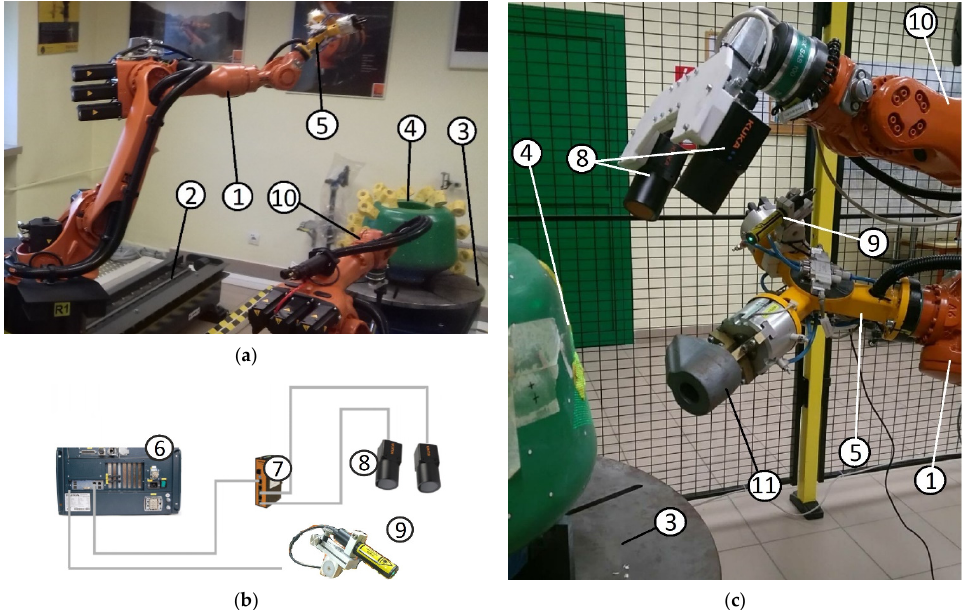
Figure 2. ( a ) Test bench, ( b ) schematic diagram of the connection of measurement instrumentation components to the robot control system, ( c ) vision system during robot positioning of the pick holder: